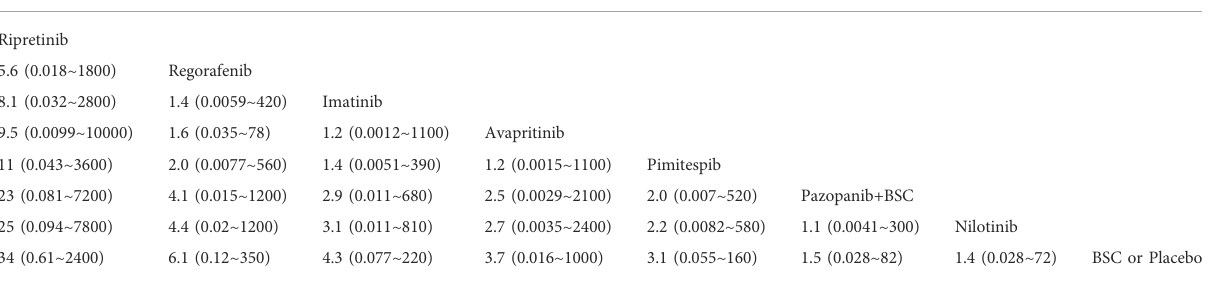
TABLE 4 Results of the network meta-analysis for